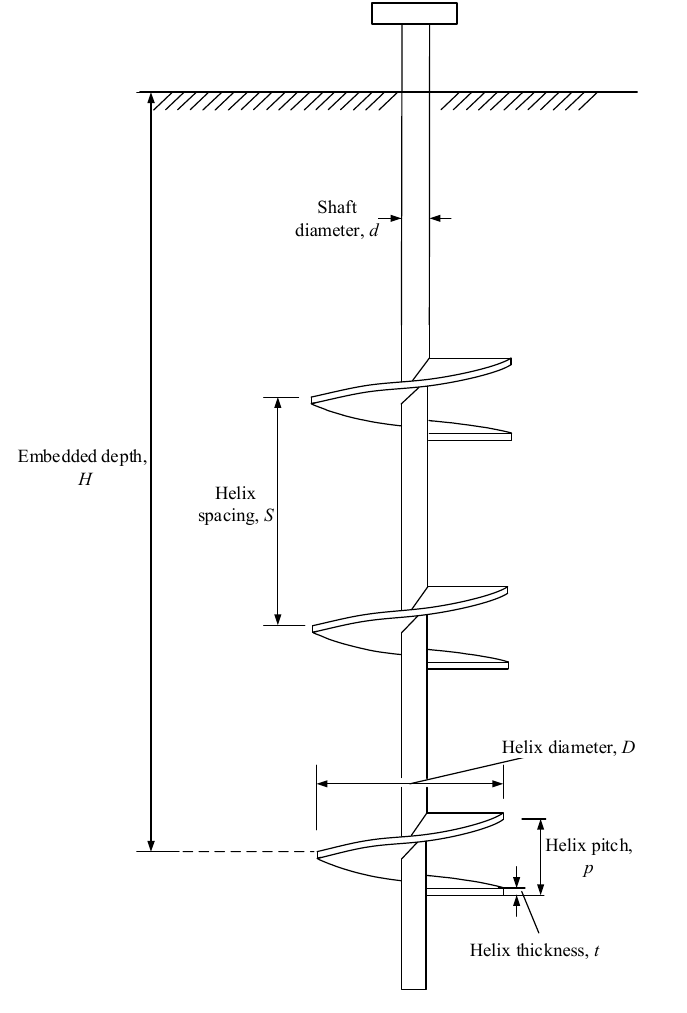
Figure 1. Helical anchor definitions.